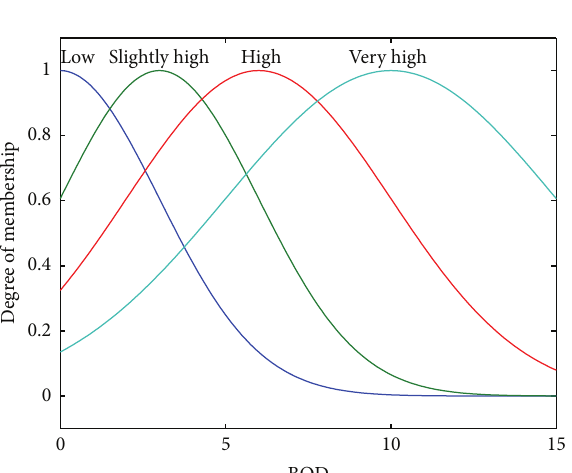
Figure 3: Dissolved oxygen.